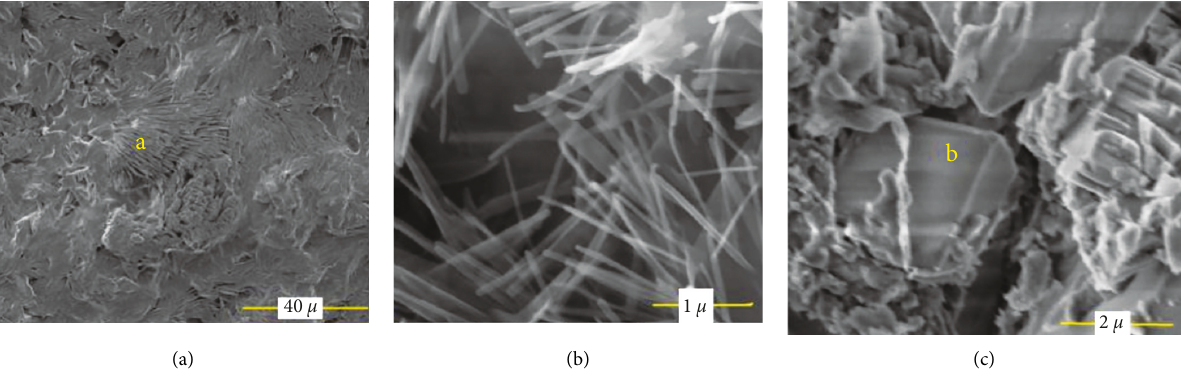
Figure 8: SEM images of crystal growth: (a) fibrous—A and B; (b) cubic–C in luffa cylindrical fiber-reinforced geopolymer composites [77]. Reproduced with permission from